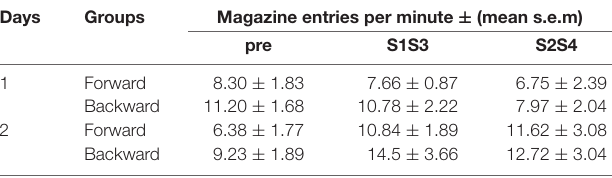
TABLE 2 | Appetitive training data for Experiment 2—Magazine entries per minute (mean ± s.e.m) in the absence (pre) or presence of the two compounds S1S3 and S2S4.